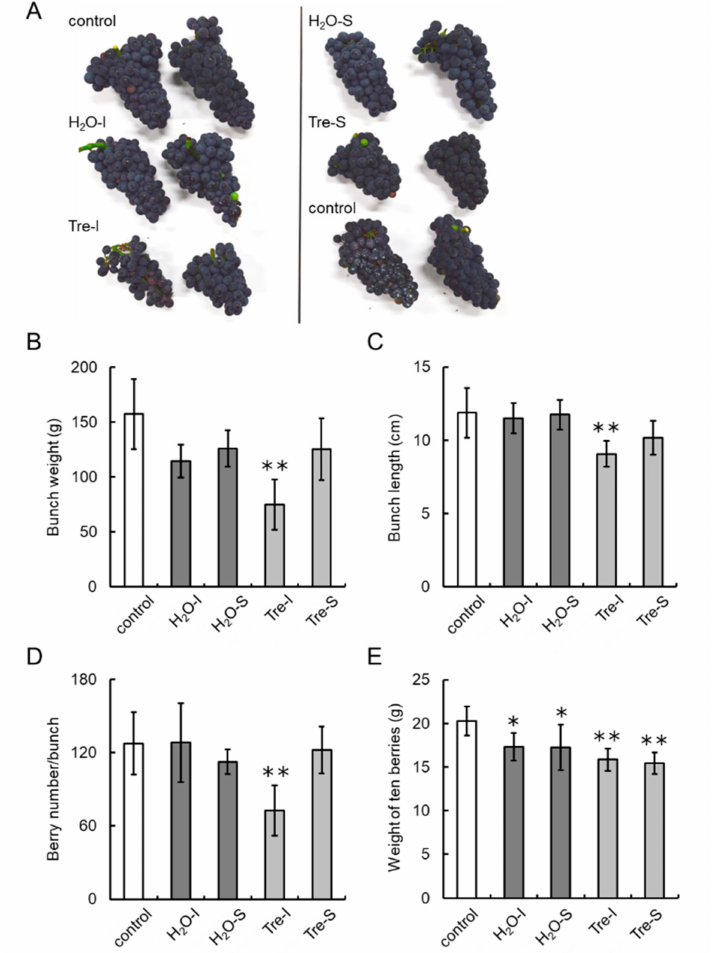
Figure 8. E ff ects of trehalose injection into buds nearing bud break on bunch characteristics in the 2018 growingseason. Tengrapevinebudsnearingbudbreak(Eichhorn–LorenzStage3)weretreatedwith10% trehalose or water using a microsyringe or an atomizer on 4 April 2018. Young shoots (Eichhorn–Lorenz Stages 5–7) from the buds were again treated with trehalose or water using an atomizer 10 days post first treatment. Twenty bunches from ten shoots (two bunches / shoot) were collected at harvest (Eichhorn–Lorenz Stage 38). ( A ) Photographs of bunches at harvest. ( B ) Bunch weight. ( C ) Bunch length. ( D ) Number of berries per bunch. ( E ) Weight of ten berries. Bars indicate means ± standard deviations of twenty bunches. * p < 0.05 compared with control (Dunnett’s test). ** p < 0.01 compared with control (Dunnett’s test). Control, non-treated grapevines. H 2 O-I, water-injected grapevines. H 2 O-S, water-sprayed grapevines. Tre-I, trehalose-injected grapevines. Tre-S, trehalose-sprayed